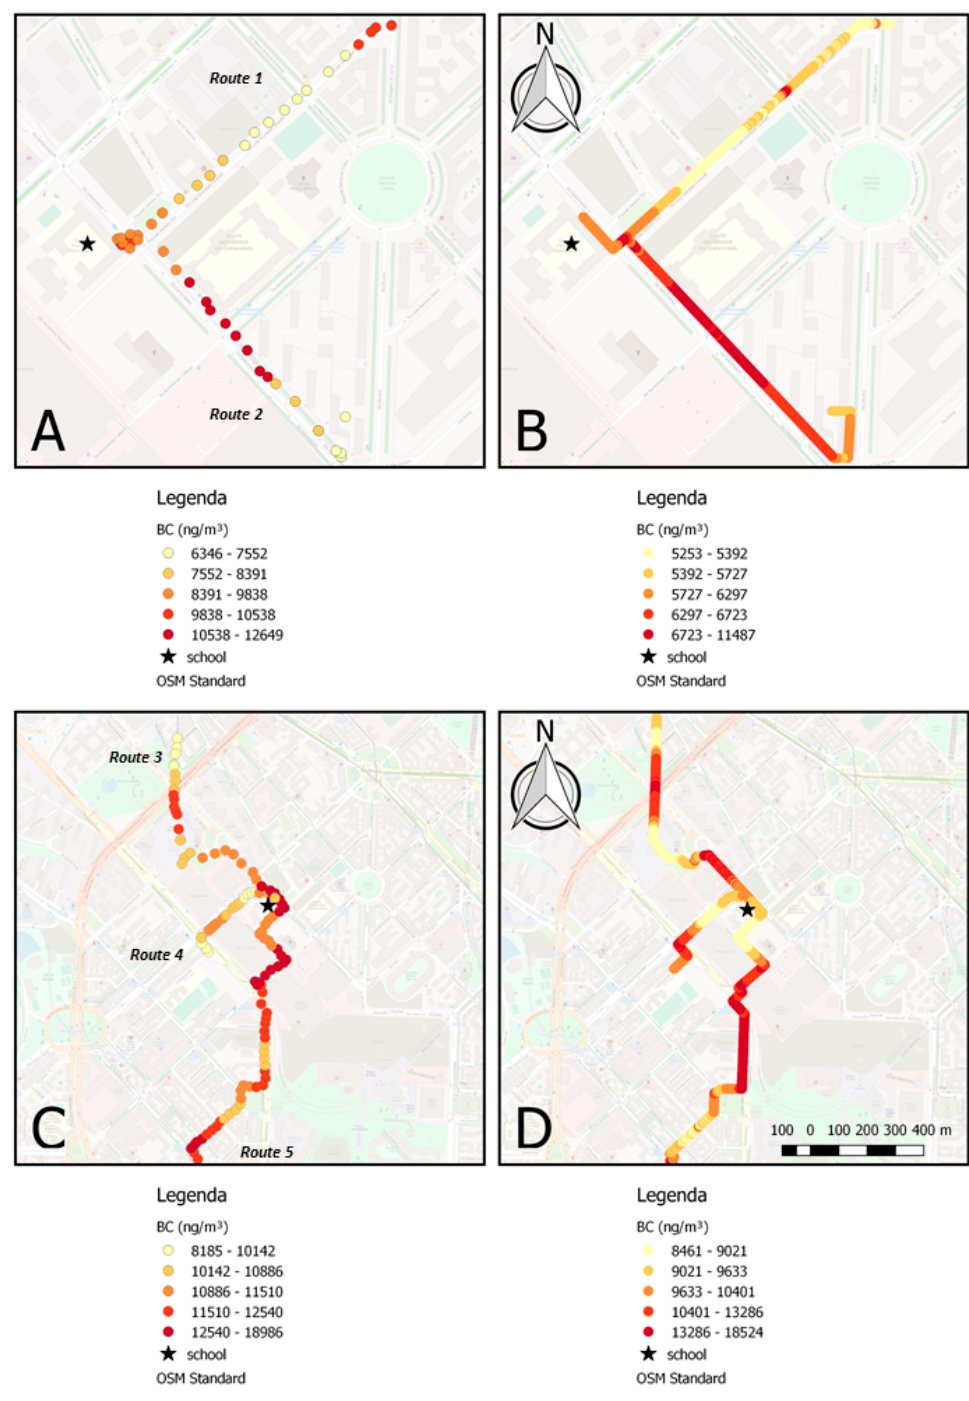
Figure 4. Visual comparison between measured BC and MRH LUR BC estimates of five different home-to school routes. In panel ( A ) and ( C ) there are the measured BC, while in panel ( B ) and ( D ) there are the corresponding MRH LUR BC estimates. The color is given by the quintile of the BC distribution for each day.